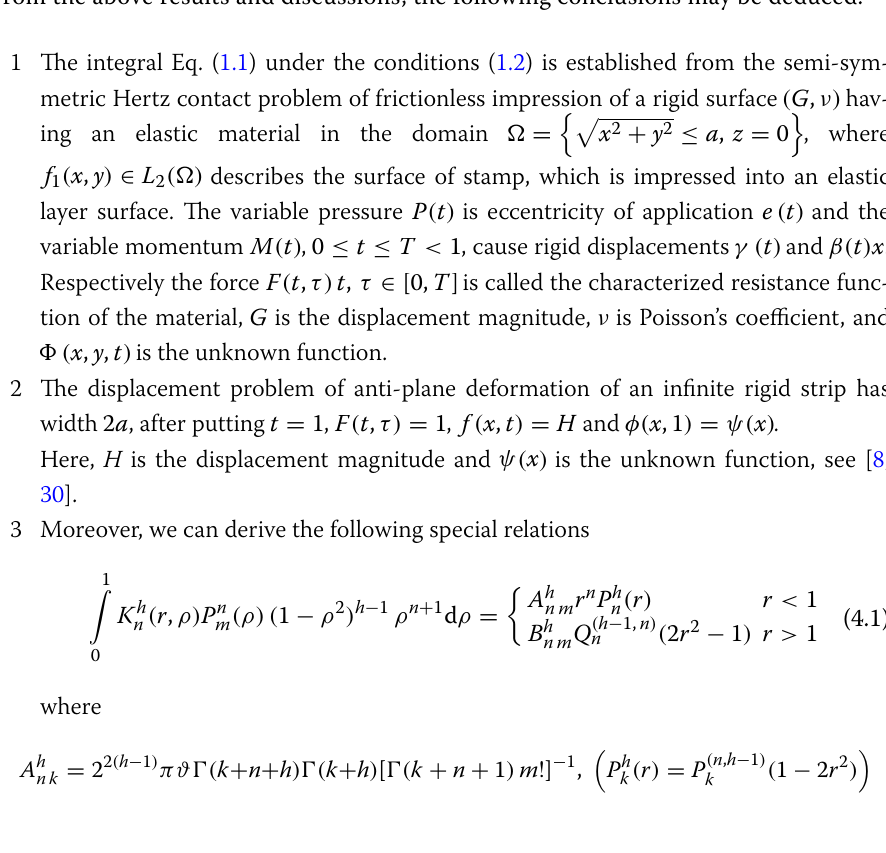
0.5, n 1 (potential = =